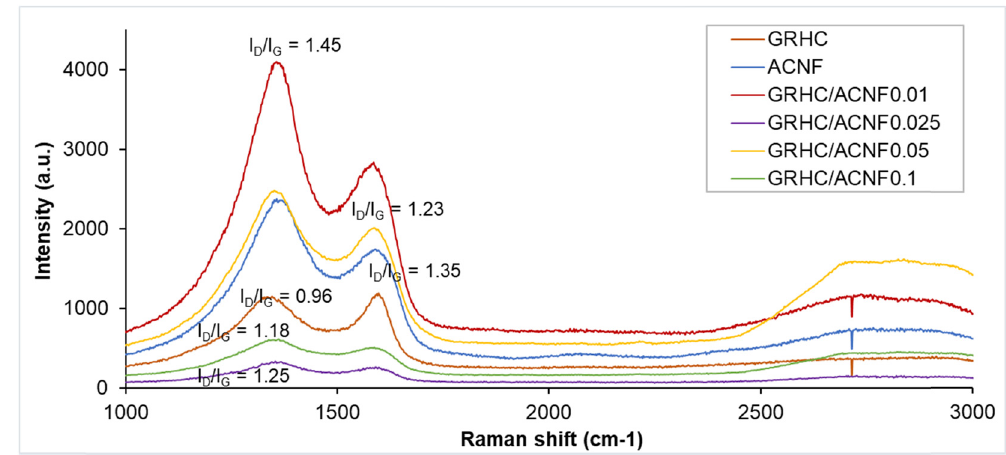
Figure 3: Raman spectra of GRHC, pristine, and composite ACNFs with di ff erent loadings of